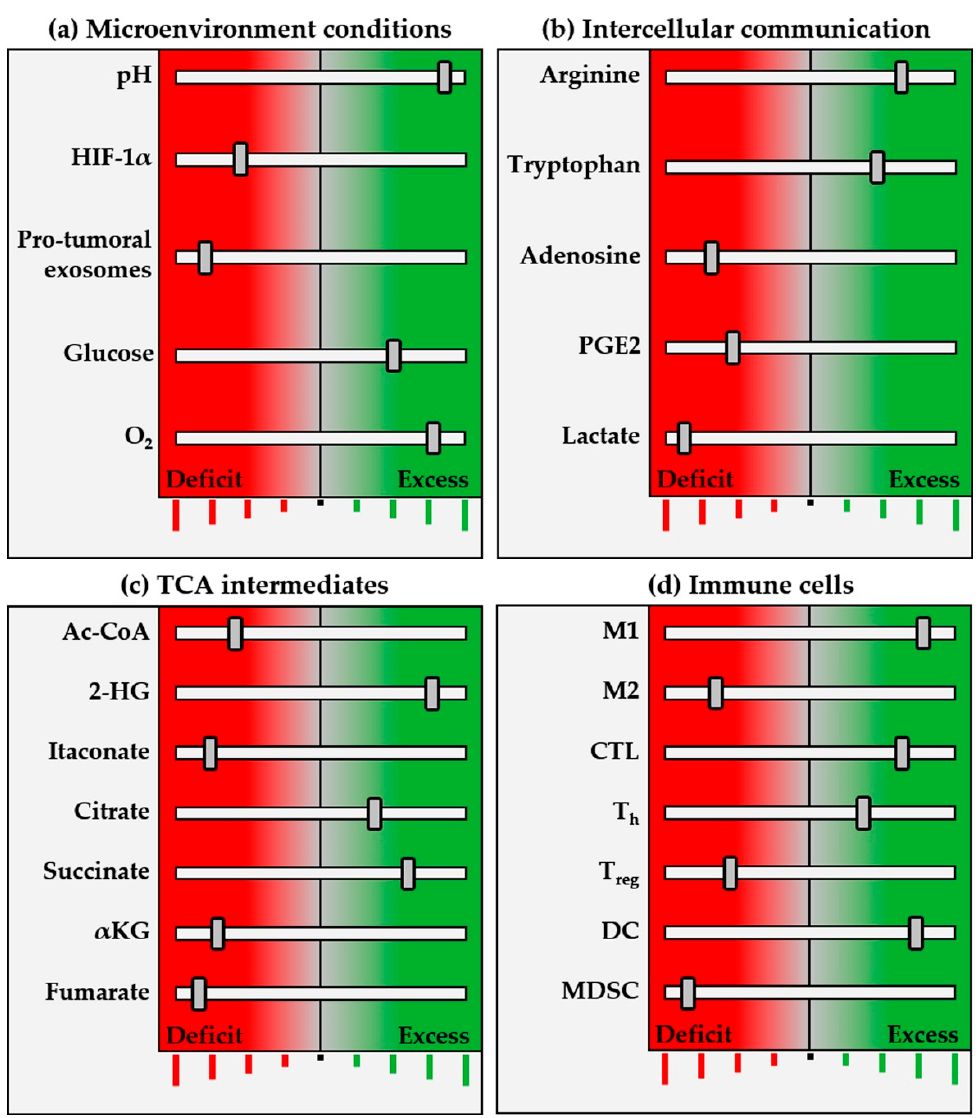
Figure 2. Schematic representation of pro ‐ inflammatory (antitumor) immunometabolic and cellular profile. Immune system programming begins at the perinatal stage, matures through environmental stimulation and is regulated by a balanced network that includes genetic and epigenetic profile, microbiota, hypothalamic–pituitary–adrenal (H–P–A) axis, sleep, diet and many other elements. Within this network, metabolism amplifies or inhibits immune function, determining physiological, adaptive or altered responses by ( a ) microenvironmental conditions, such as pH, oxygenation, etc.; ( b ) intercellular communication with chemokines, lactate, PGE2, etc.; and ( c ) TCAis, such as succinate, α -KG and others. The figure shown represents different frequency (inhibition/activation) bands, with an equilibrium position in the center, decreased activity towards the left (red), and increased towards the right (green). Like an equalization system, this network selects the immune “frequency band” determined by fine-tuning the elements making up the expanded system. This determines the immune response pattern, defined by cell subpopulations ( d ), their functionality, cytokine secretion and intercellular communication relationships within the TME. This schema introduces a concept that must be investigated and determined separately for each type of immune response, depending on specific physiological or